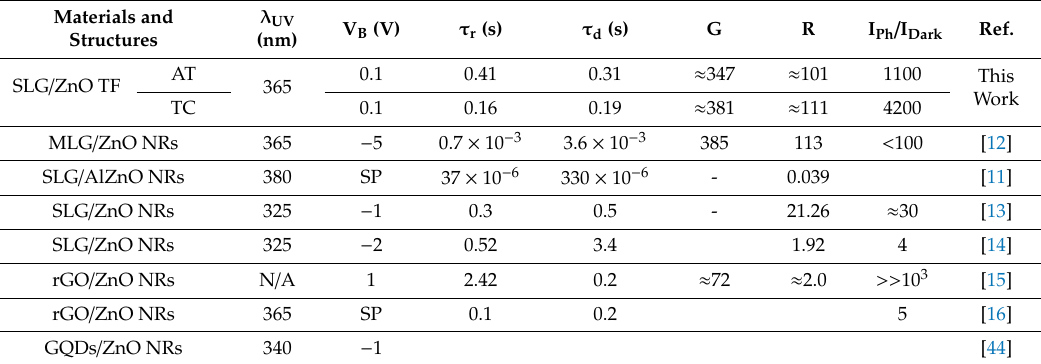
Table 1. Comparison of the photoresponse characteristics for various types of graphene / ZnO-based Schottky